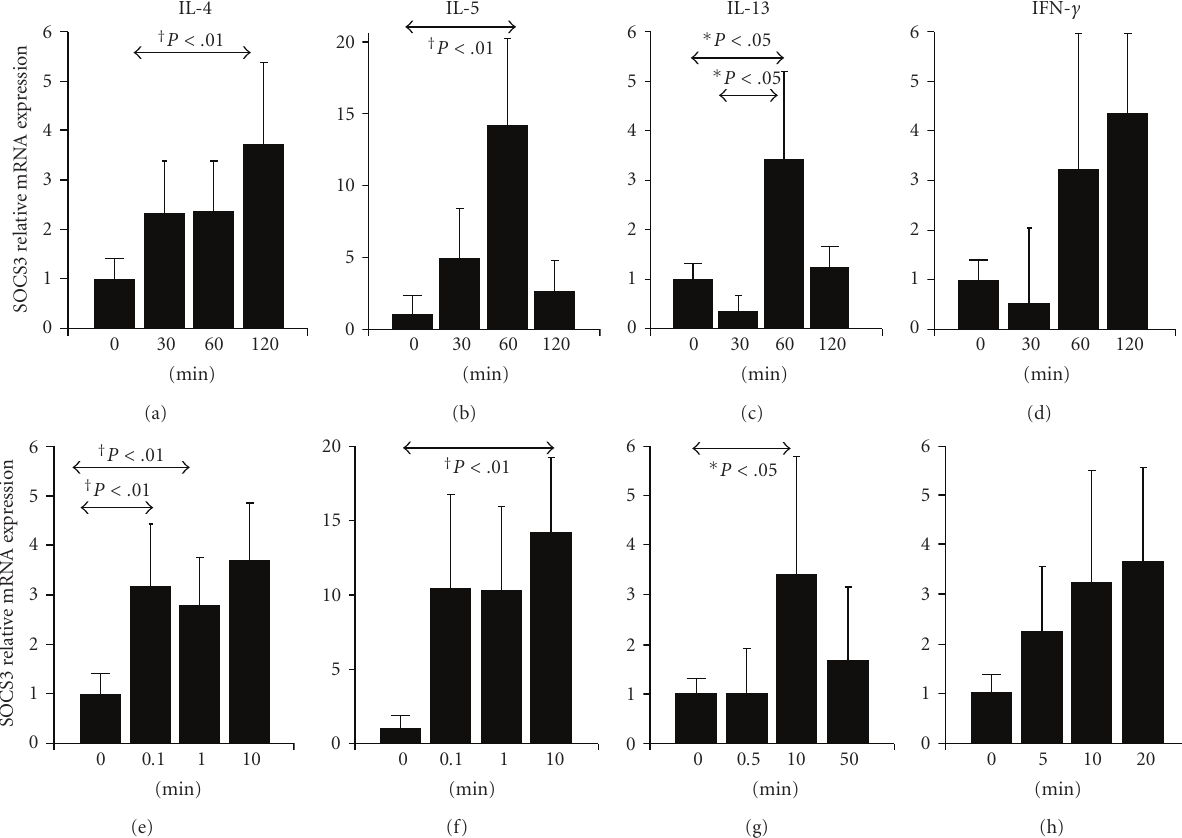
Figure 3: SOCS3expression in peripheral blood eosinophilstreated with Th2 cytokines and IFN- γ . Purified eosinophilsfrom healthy donors were cultured with 10 ng/mL of IL-4 (a), IL-5 (b), IL-13 (c), or IFN- γ (d) for di ff erent periods of time. Dose-response curves were performed with IL-4, IL-5, IL-13, or IFN- γ (e)–(h) at maximal time response; SOCS3 mRNA was measured by real-time quantitative PCR. The results are expressed as a fold induction relative to untreated eosinophils, and significant di ff erences are indicated. Data represent the geometric mean ± SD from four individuals, and each measure was performed in